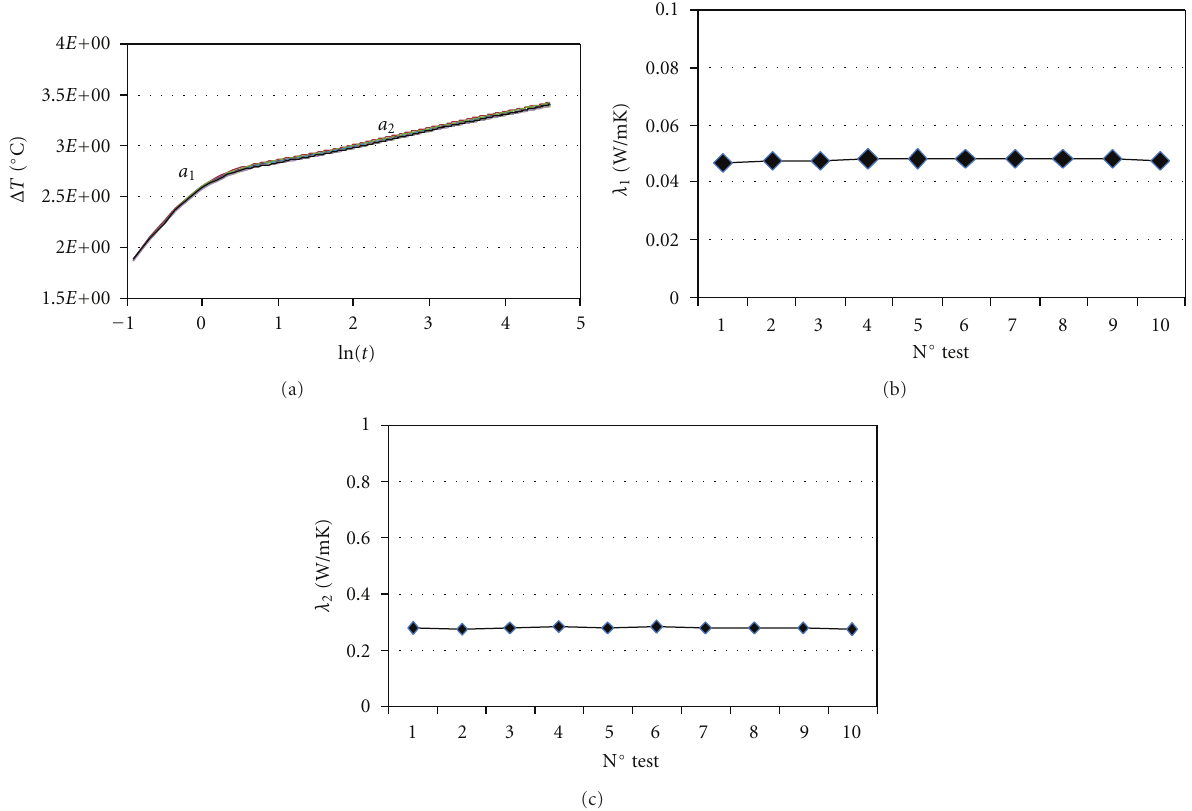
with a the curve slope ( a = Δ T/ Δ ln( t )), R the